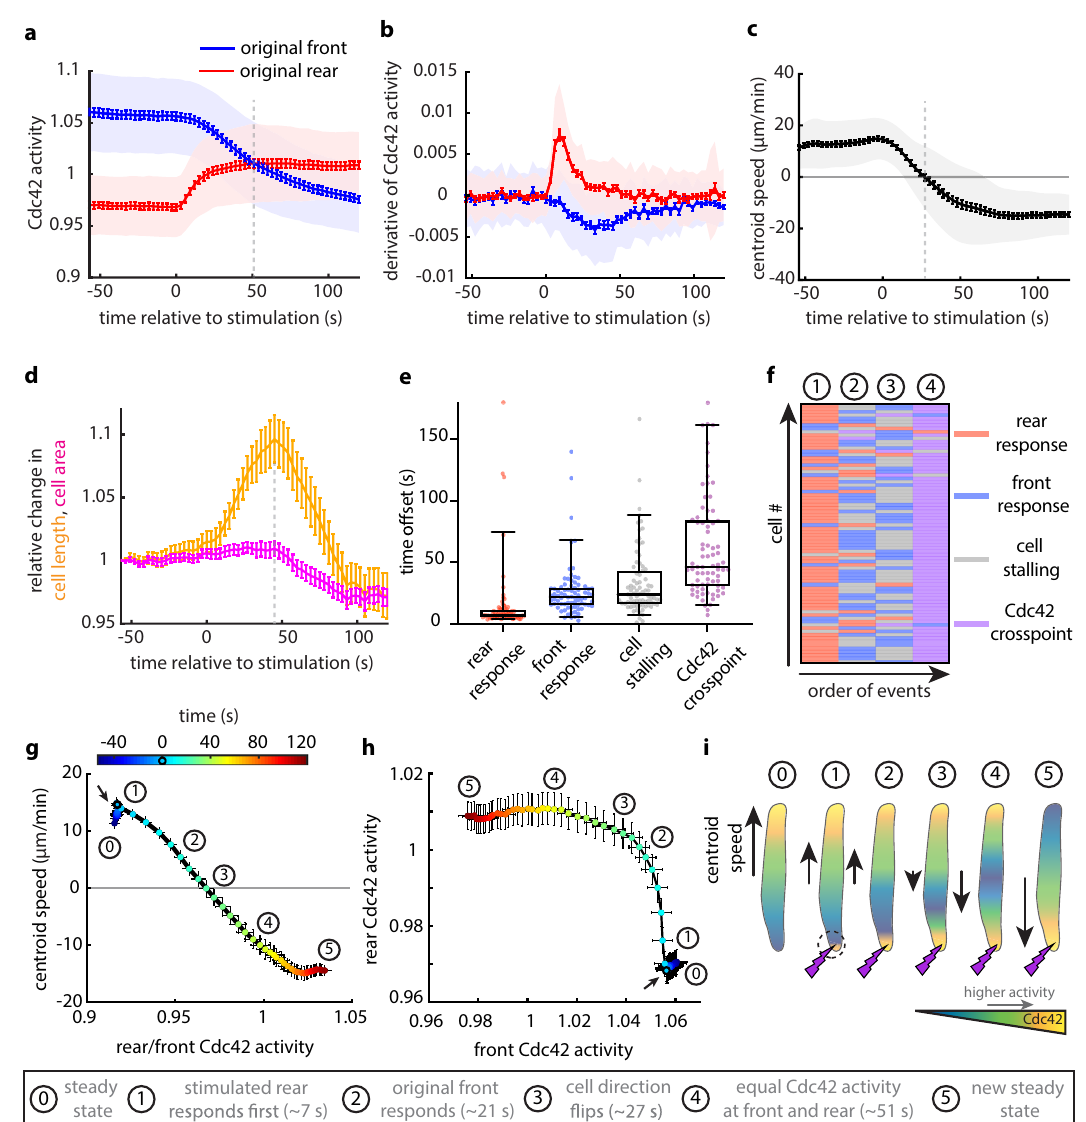
Fig. 2 In reversing cells, Cdc42 activation at the stimulated original rear begins immediately and cells reverse their direction of migration before Cdc42 activity fl ips polarization. a , b Mean magnitude ( a ) and derivative ( b ) of Cdc42 activity at the original cell front (blue) and rear (red) over time (lines: means, shaded regions: SD, error bars: mean value ± SE). Data are averages from n = 78 reversed cells from 36 independent experiments. Dashed vertical line in a shows the Cdc42 cross-point. c Centroid speed of cells that reversed their migratory direction over time (line: mean, shaded region: SD, error bars: mean value ± SE). Data are averages from the same 78 cells shown before. Dashed vertical line indicates when cell stalling (zero speed) occurs. d Relative change in cell length (orange) and cell area (magenta), both normalized to the initial length and area for each of the same 78 cells (lines: means, error bars: mean value ± SE). Dashed vertical line indicates the time when the relative change in cell length reaches maximum value. Note that the normalized area appeared to decrease post stimulation, overshooting below the starting value. This relative decrease in cell area was associated with a smaller rear after repolarization. Moreover, the Cdc42 activity at the new emerging front was restricted in a smaller depth as compared to the pre-stimulus steady state (Supplementary Movie 1), suggesting that the repolarized cell adopted a sharper Cdc42 activity pro fi le with a more constricted rear. e Box plots of the time offset for rear response, front response, cell stalling, and Cdc42 cross-point for the same 78 cells that reversed. Box plots extend from the 25th to the 75th percentiles; lines inside box plots represent the medians and whiskers are drawn to the 5th percentile and up to the 95th. f Heat map of the order of events (columns) across the 78 reversed cells shown before (rows). Circled numbers correspond to the cell states shown in i . g , h Phase diagrams of mean centroid speed vs. mean rear/front Cdc42 activity ( g ) and of mean rear vs. mean front Cdc42 activity ( h ), averaging over the same 78 reversed cells. Colored points correspond to the average cell state at different time points relative to the start of the persistent pulsated stimulation (black circle/arrow). Circled numbers indicate the cell states as summarized in i and error bars denote mean value ± SE. i Cartoon depiction of the average order of events for a cell that reverses. Source data are provided as a Source Data fi